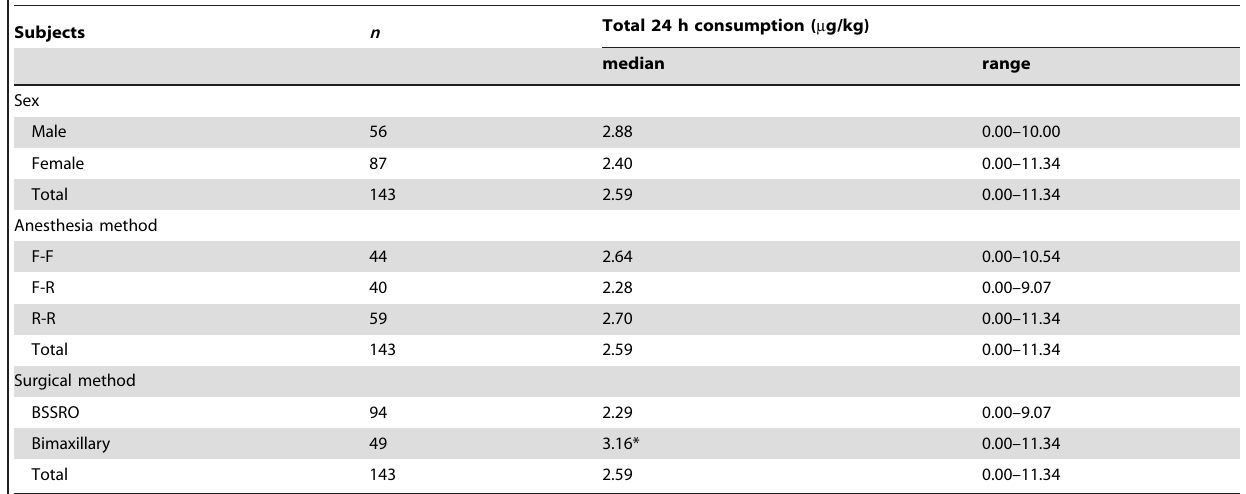
Table 2. Total postoperative 24 h consumption.